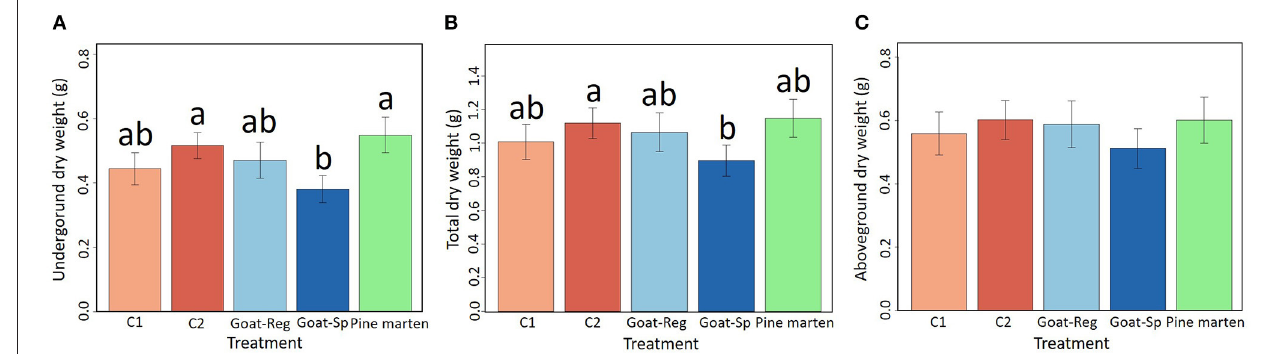
FIGURE 7 | Model-adjusted means ( ± SE) of seedling underground dry weight (A) , seedling total dry weight (B) , and seedling aboveground dry weight (C) for the five treatments (C1 or “control seeds with pulp”, C2 or “manually-depulped control seeds”, Goat-Reg or seeds regurgitated by goat, Goat-Sp or seeds spit out by goat, and Pine marten or pine marten-ingested seeds). Different letters denote significant differences between paired levels in Tukey test.